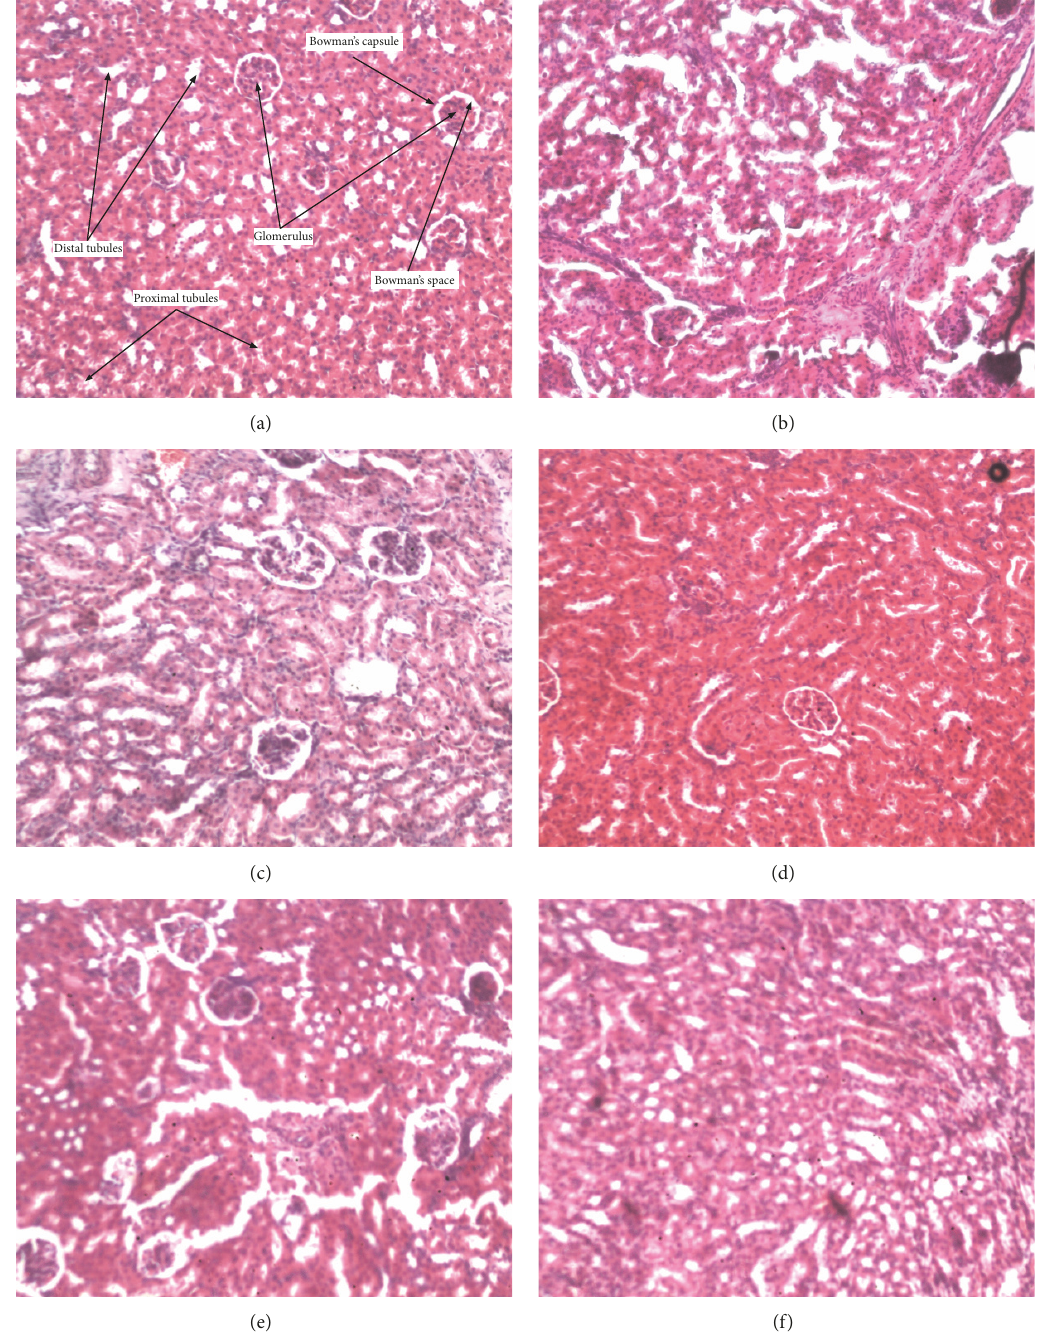
Figure 2: Photomicrograph of the sections of the kidney in control rats (a) and rats treated orally with 30 mgkg −1 (b), 100mg kg −1